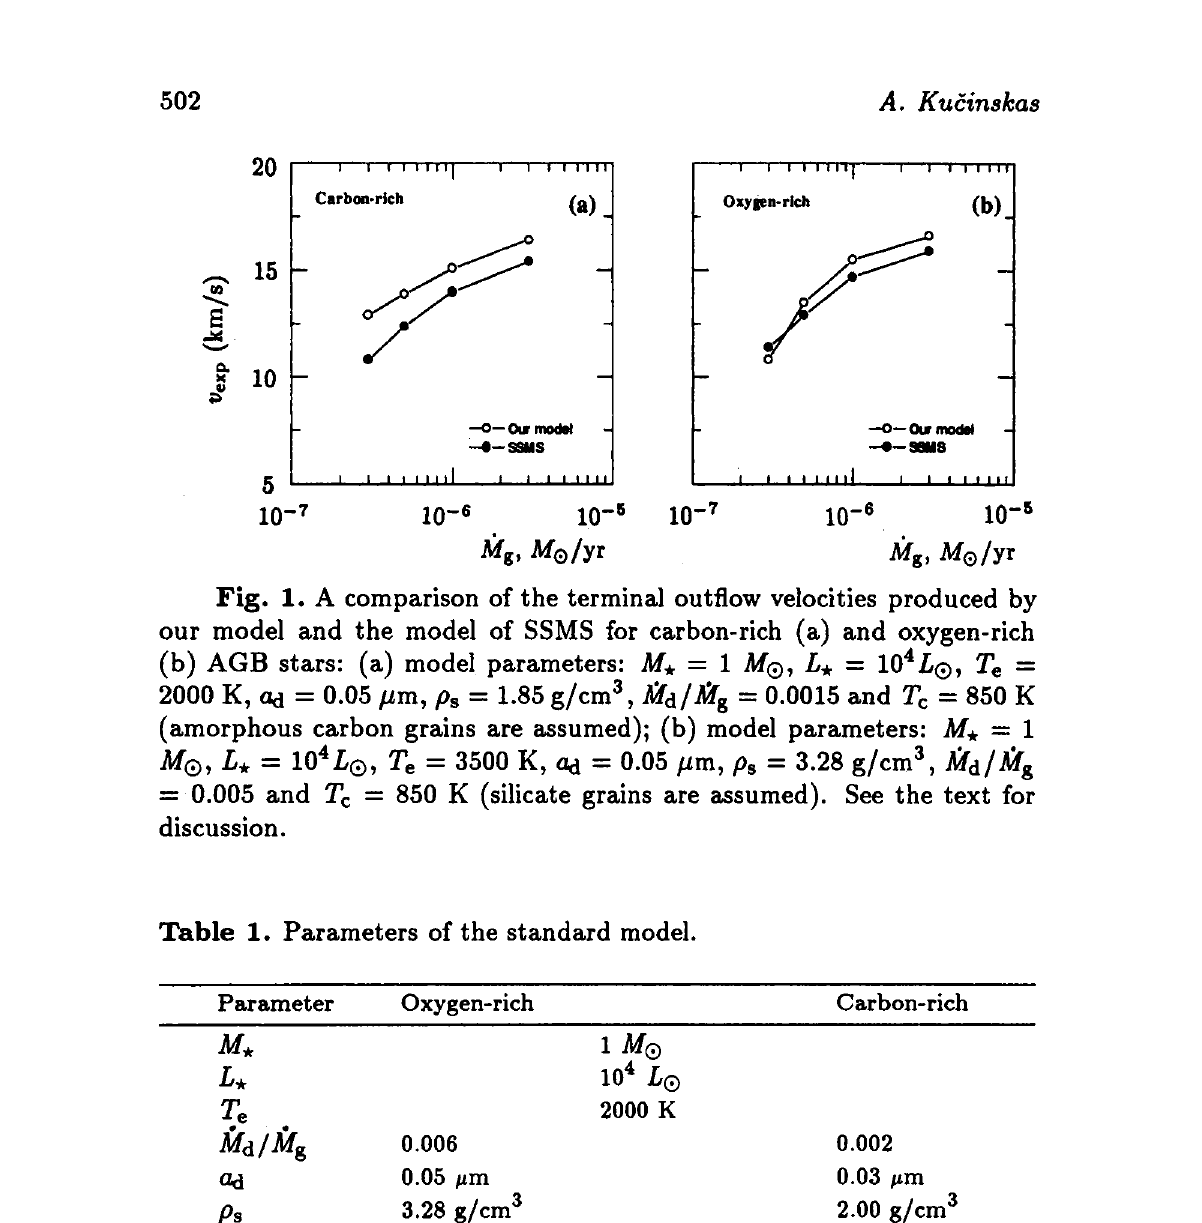
Table 1. Parameters of the standard model. Parameter Oxygen-rich